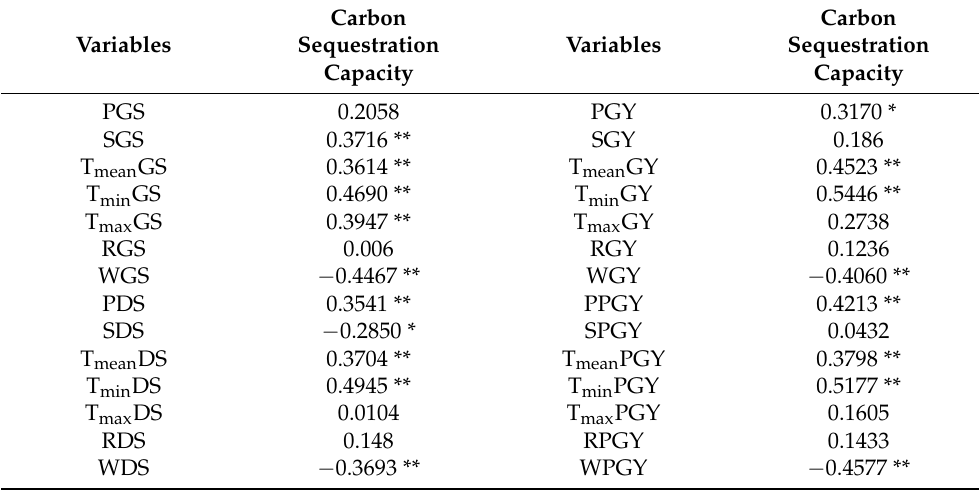
Table 3. Correlations between climatic variables and carbon sequestration capacity of P. schrenkiana in the Tianshan Mountains.